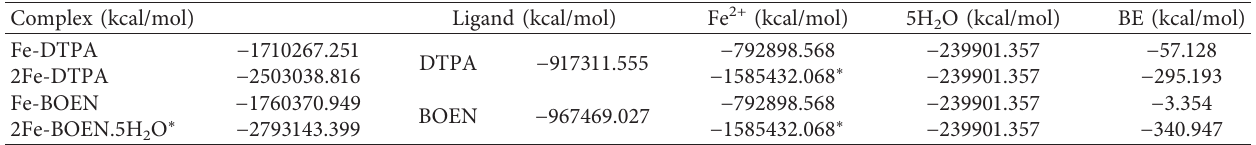
Table 6: Calculated binding energies (BE) of the DTPA and BOEN complexes. Complex